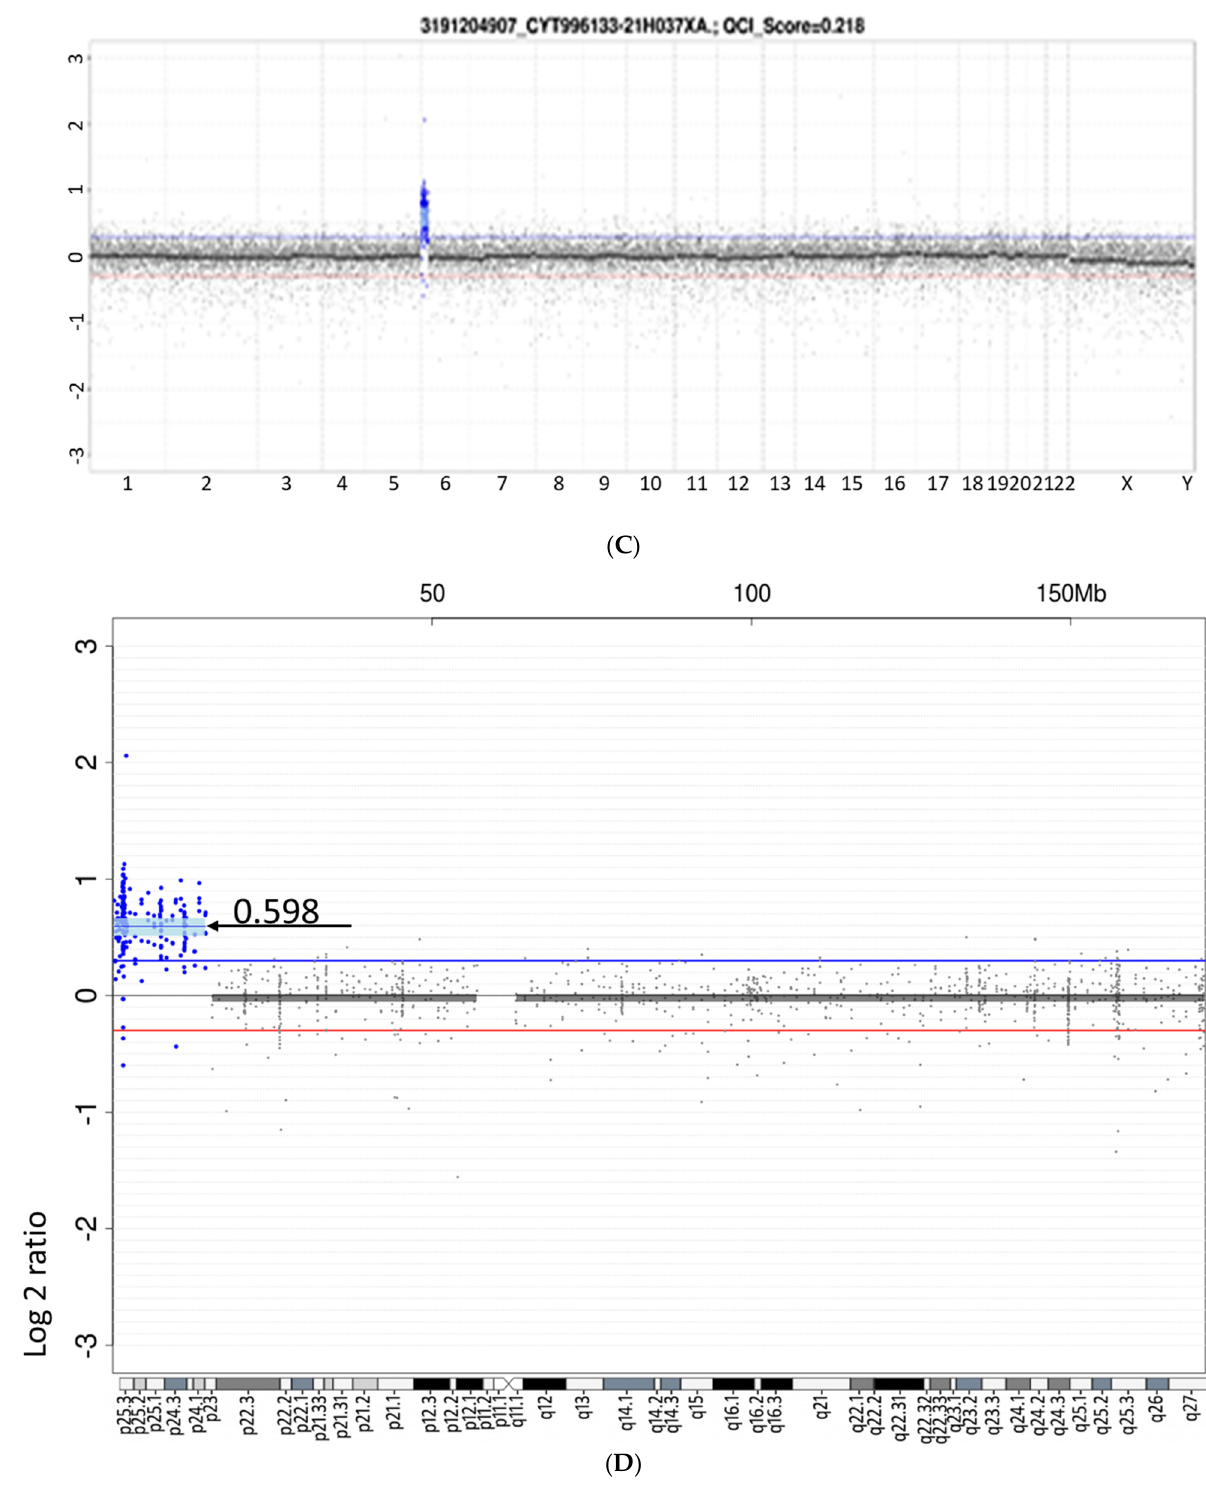
Figure 2. Cytogenetic and molecular genetic study results of our proband. ( A ) Karyotyping of abnormal cells with marker chromosomes at birth. ( B ) Repeated karyotyping of abnormal cells with marker chromosomes at 3 months of age. ( C , D ) Array comparative genomic hybridization studies (aCGH) revealed a partial 6p duplication of 14.337Mb at arr[GRCh37] 6p25.3p23 (211198_14548093) × 3–4 with a log2 ratio of 0.598.